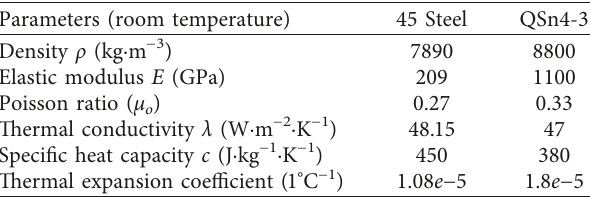
Figure 1: The structure of lock ring synchronizer. Table 1: Primary material